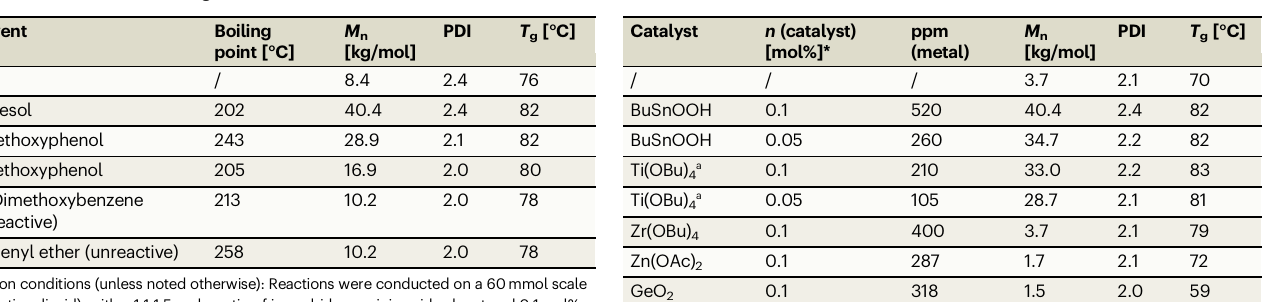
Table 1 | In fl uence of aryl alcohol on poly(isosorbide succinate) molecular weight and T